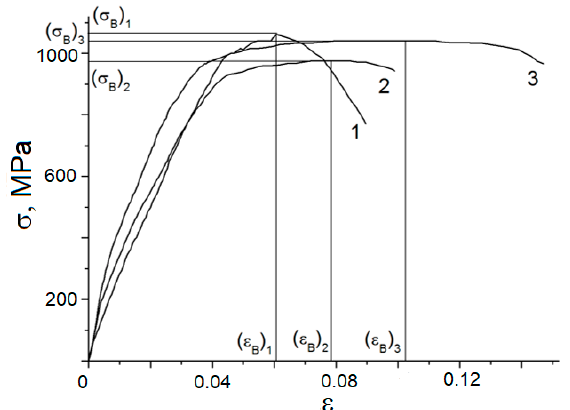
Figure 2. Stress–strain diagrams of Ti-Al-Mo-V alloy: center of the workpiece (1), surface layer (2), transition layer (3).